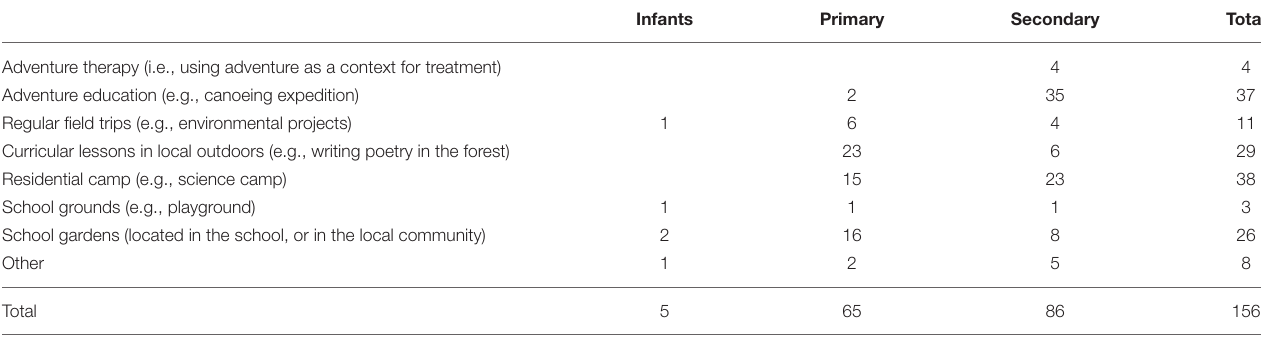
TABLE 1 | Outdoor learning contexts by participant age.